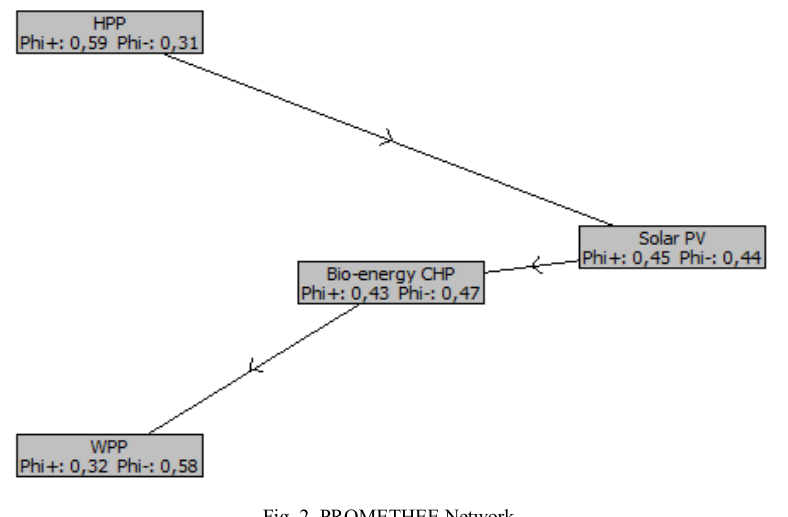
Fig. 2. PROMETHEE Network.